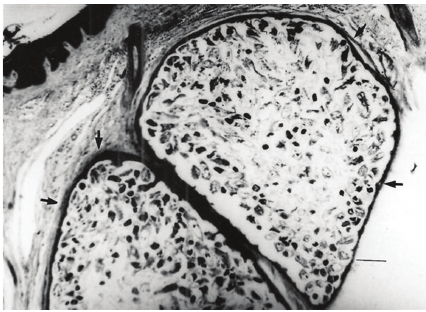
Figure 8: Saccular distension of adjacent hair follicles with Demodex bovis mites and associated bacteria, forming large colonies of demodectic mange (bladder-like cysts) in skin sections from an infected cow. Note extremely stretched and jagged epithelial lining (black arrows). Haematoxylin and Eosin. Scale bar: 200 𝜇